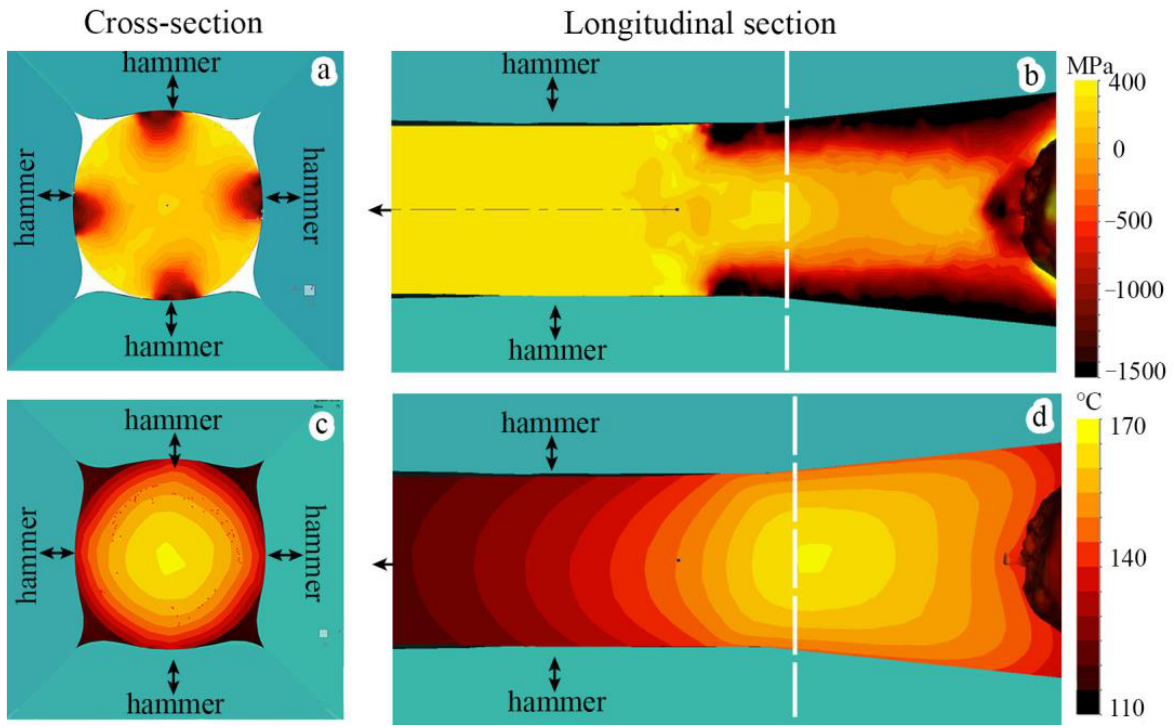
Figure 9. ( a , b ) Tensile – compressive stress distribution and ( c , d ) temperature during the fourth step of cold rotary swaging. White dashed lines in ( b ) and ( d ) mark the location of cross-sections (( a ) and ( c ), respectively).